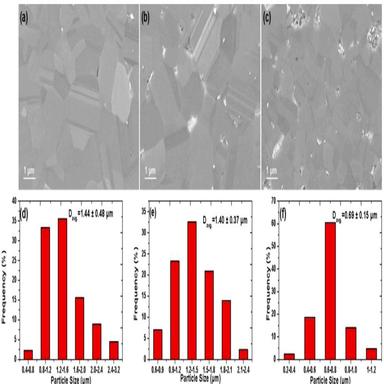
(a-c) is the polished surface of SiC,CCN/ SIC-2.5 wt% and CCN/ SIC-7.5 wt% samples, respectively, and (d-f) is the grain size distribution of the SiC matrix in the corresponding sample.